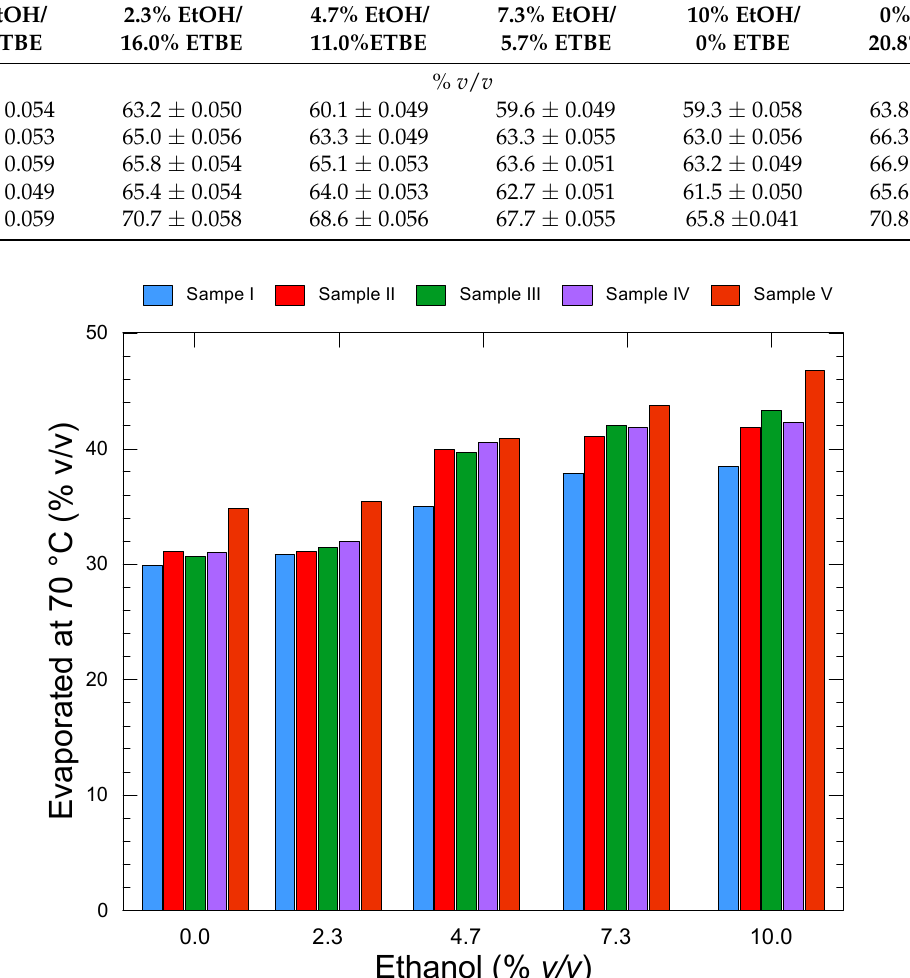
Figure 8. E70 values for all blends against bio-ethanol content.